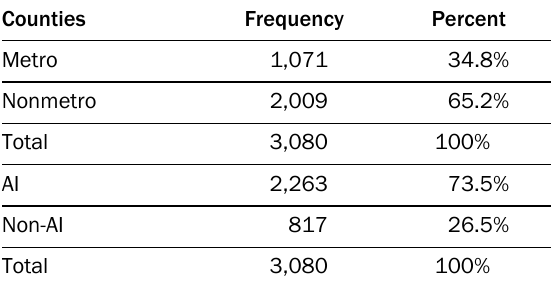
Table 1. Frequency and Percent of Metro and Agriculturally Important (AI) Counties,